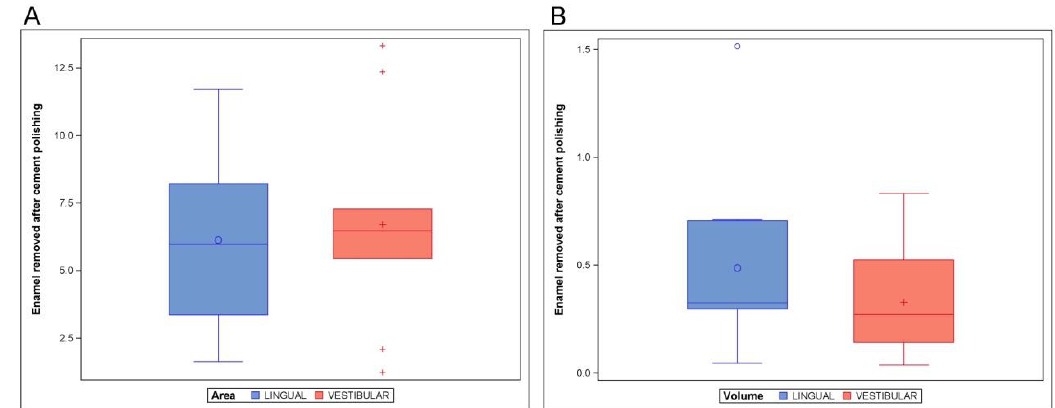
Figure 7. Boxplot of the area ( A ) and volume ( B ) of enamel removed after cement polishing of the lingual and buccal multibracket appliance therapies. The horizontal line in each box represents the respective median value of the study groups. Blue represents lingual multibracket appliance and red represents buccal multibrackets appliance.